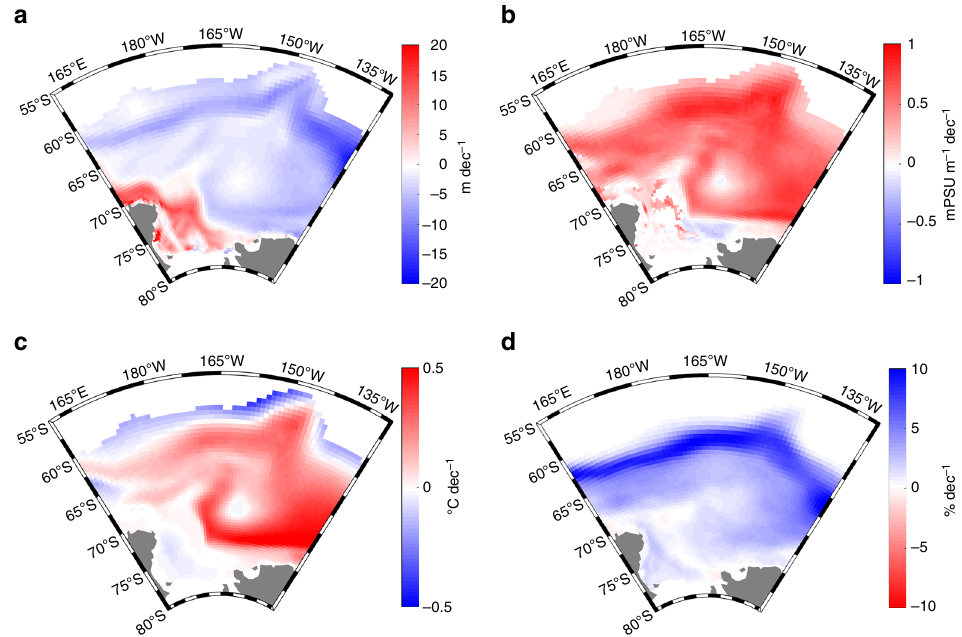
Fig. 3 1979 – 2013 model trends in upper ocean properties in the Ross Sea. 1979 – 2013 model trends in a mixed layer depth, b near-surface vertical salinity gradient, c ocean temperature at depth, and d sea-ice concentration in the sea-ice-covered region of the Ross Sea. In c , temperature trends are shown at the depth at which they are maximum, within the upper 300 m. Except in the southernmost Ross Sea where MLD increases a , the depth of this maximum is always greater than the local mean MLD (Supplementary Fig. 3). This depth is also used as the lower boundary of the column over which salinity gradients of b are